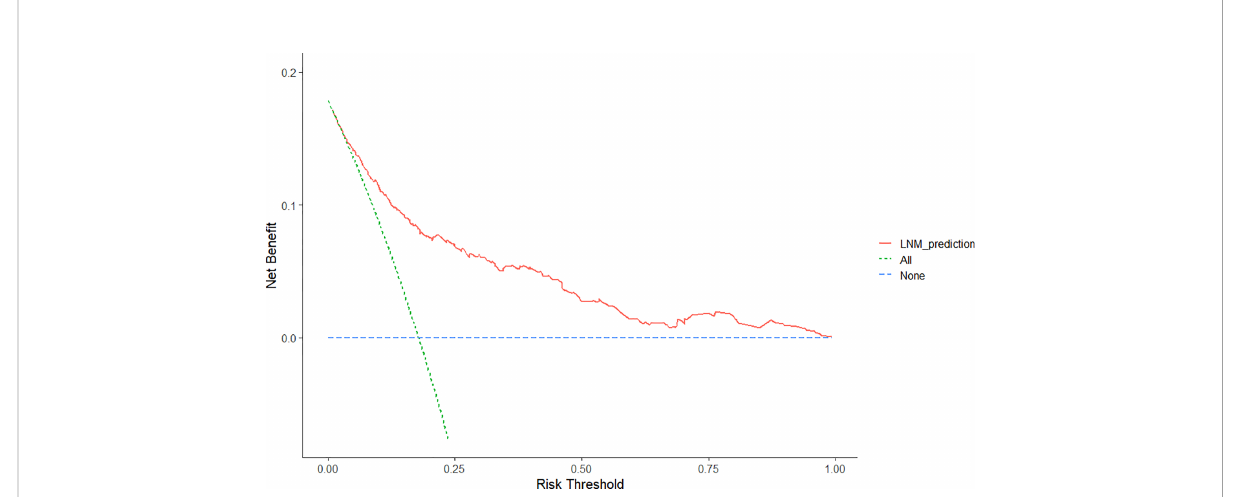
FIGURE 5 Decision curve analysis for the nomogram for the prediction of lymph node metastasis after endoscopic submucosal dissection in early gastric cancer. The y-axis represents net bene fi ts, calculated by subtracting the relative harms (false positives) from the bene fi ts (true positives). The x- axis calculates the threshold